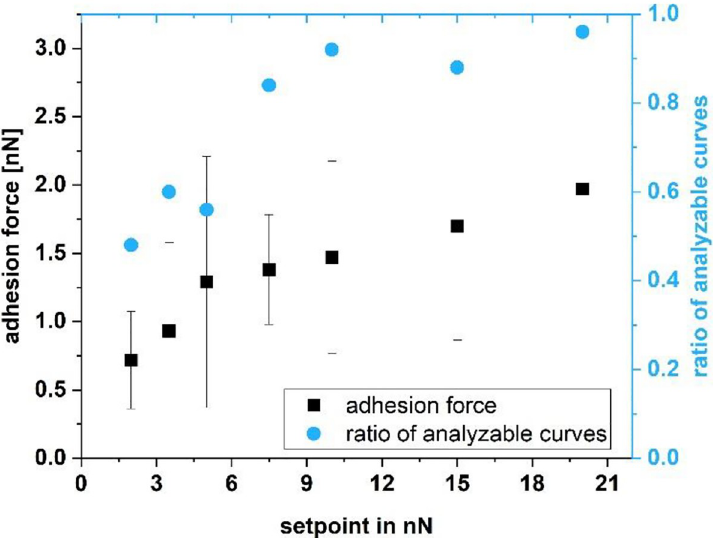
Fig 2. Adhesion force and ratio of analyzable force-distance curves of a single Lactococcus lactis cell on glass as a function of the setpoint; each data point comprises 25 force-distance curves.